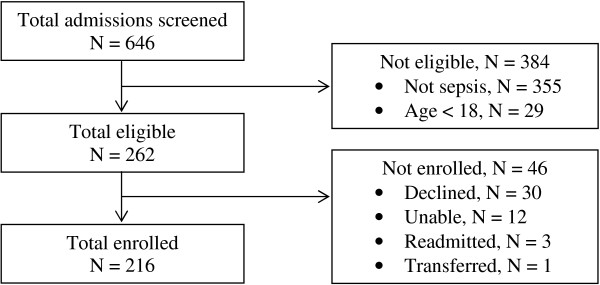
Flow diagram of patient enrolment for the study.